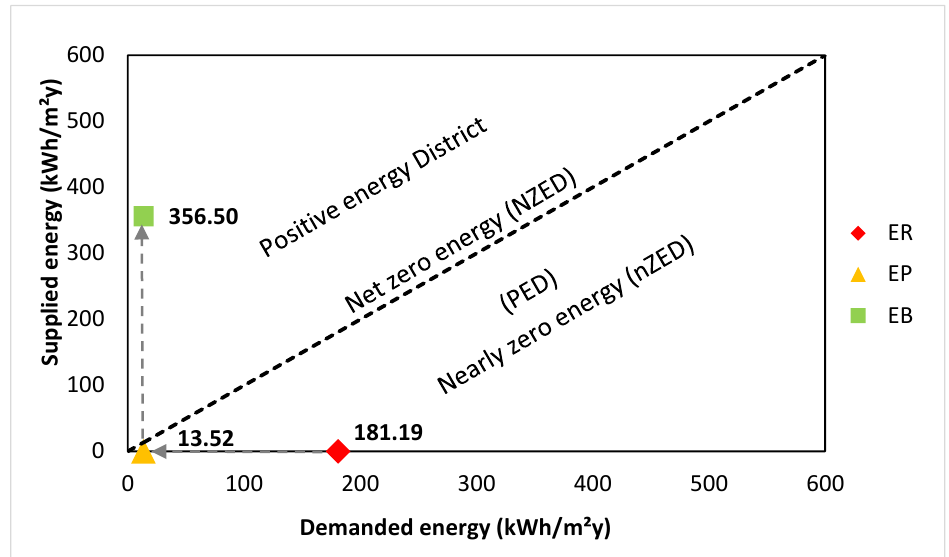
Figure 15. Graphical representation of ZED values for case study models in terms of primary energy, adapted from [48].